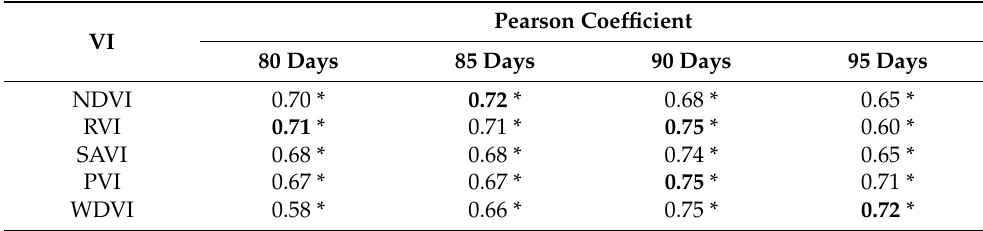
* Correlation is significant at the 0.05 Table 4. The Pearson coefficient representing the relationships between the derived VIs and the yield of the Dexter hybrid.